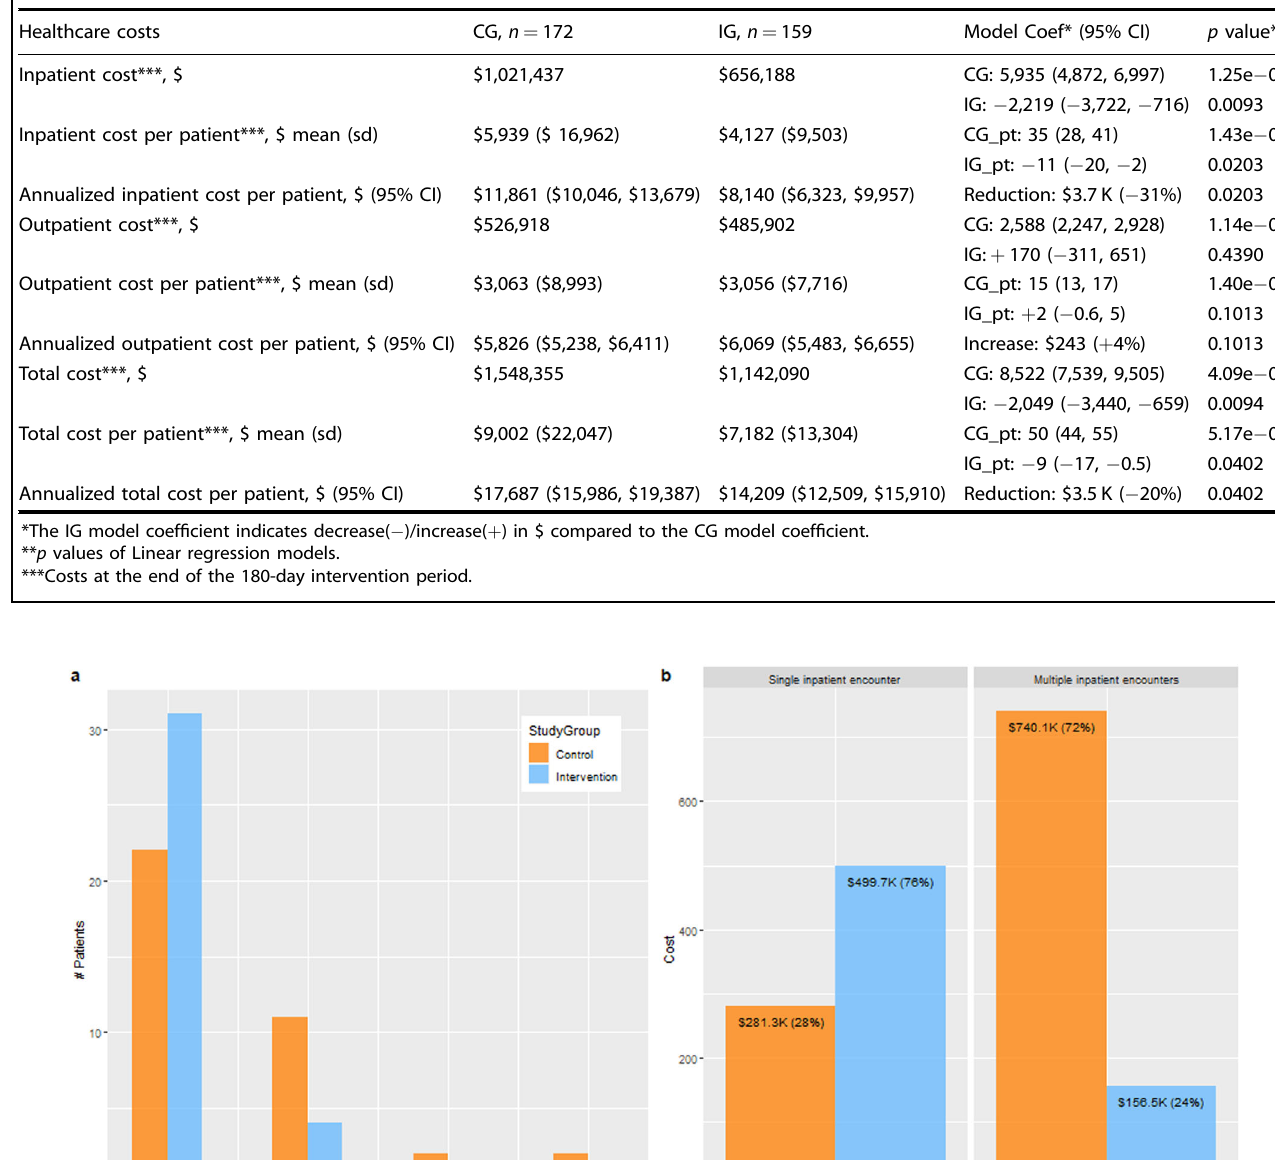
Table 4. Healthcare cost regression results between groups.